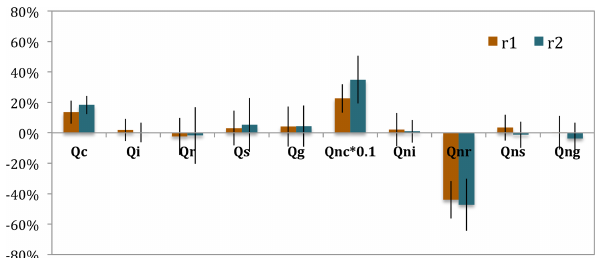
Figure 8. The mean differences in percentage of FFBB to FF (i.e., (FFBB-FF) / FF × 100%) over all convective cases during the fire periods in the Sumatra region (r1) and the Borneo region (r2). Q c , Q i , Q r , Q s , and Q g represent cloud, ice, rain, snow, and graupel mass concentrations, respectively. Q nc , Q ni , Q nr , Q ns , and Q ng are the number concentration for each hydrometeor. The error bars represent a single standard